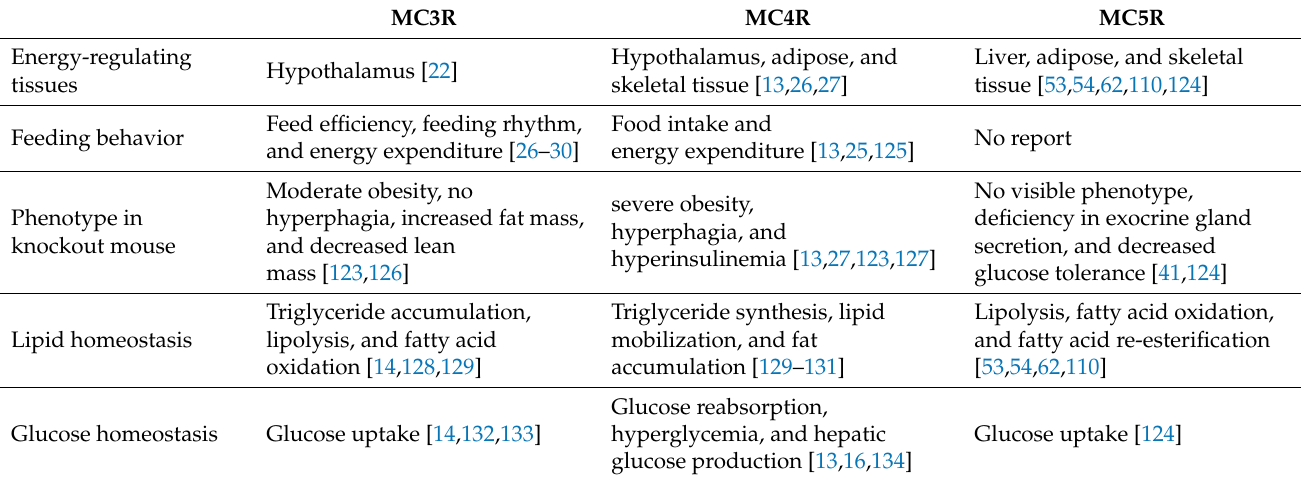
Table 3. Functions of MC5R, MC4R, and MC3R in regulation of energy homeostasis.